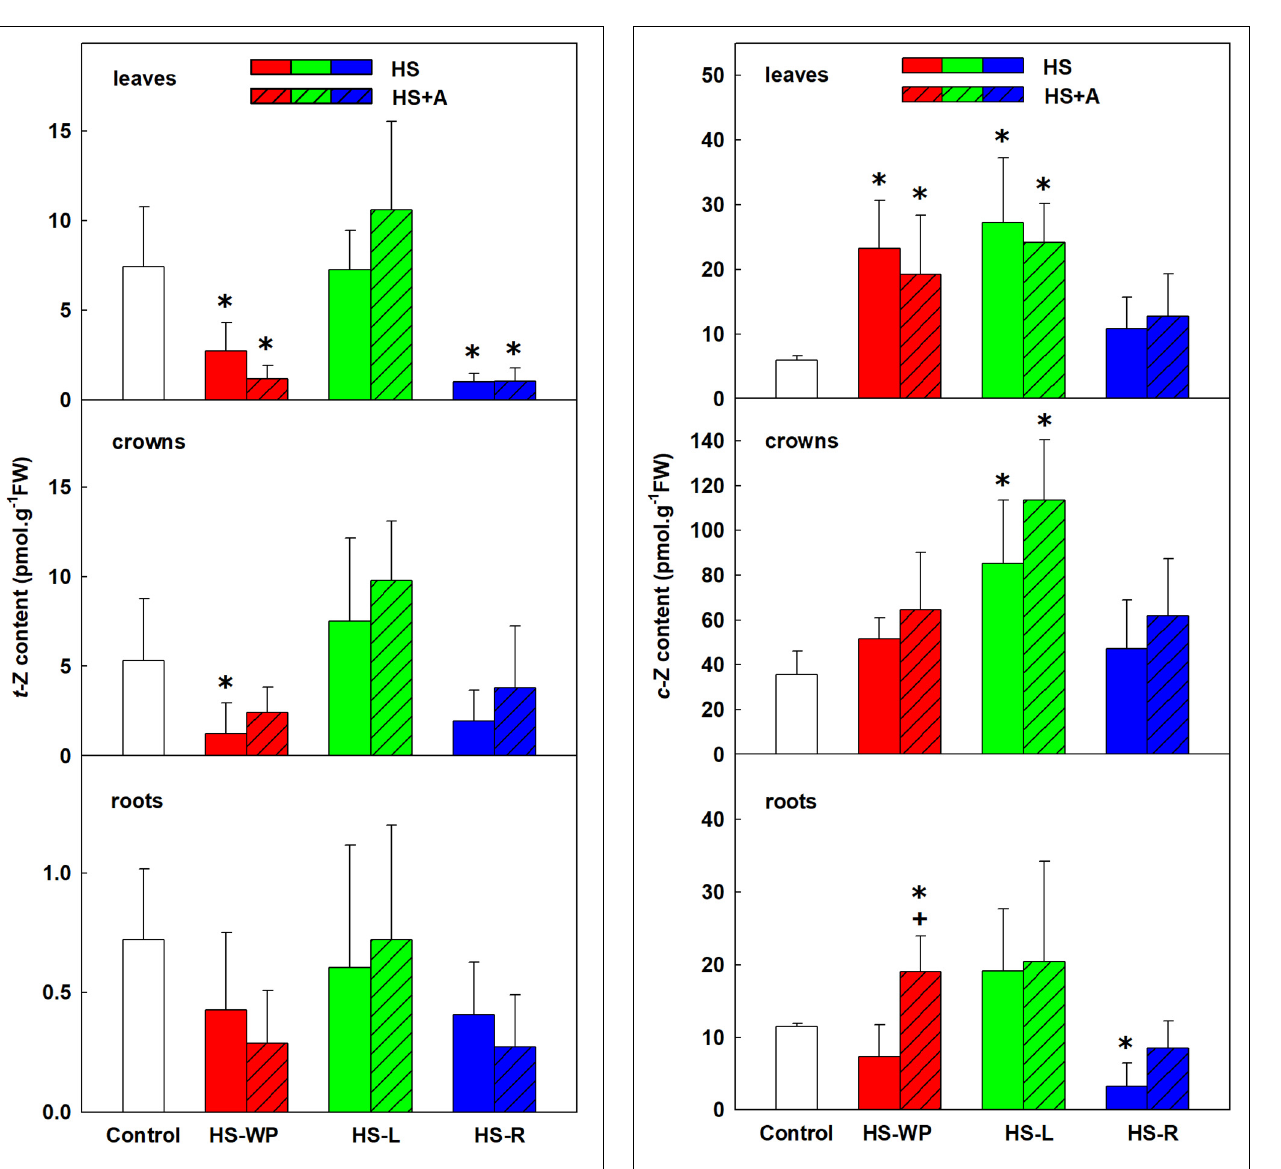
FIGURE 6 | The content of cytokinin trans- zeatin (tZ) in leaves, crowns and roots of rice seedlings exposed to heat stress directly (HS) or after acclimation (HS + A). Heat stress was applied to whole plants (HS-WP), to leaves (HS-L), or to roots (HS-R). Data are means ± SD. One-way ANOVA with Tukey’s post hoc test ( p < 0.05, n = 6) was used to compare controls to the HS treatments. Significant differences compared to control plants are indicated by asterisks ( ∗ ).